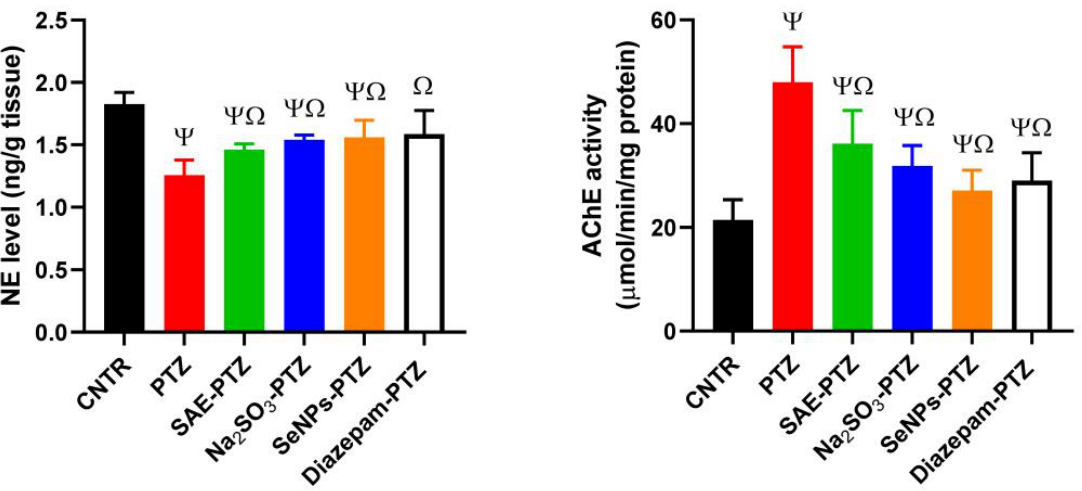
Figure 7. Effects of oral administration of Syzygium aromaticum extract (SAE), sodium selenite (Na 2 SeO 3 ), and green synthetized SeNPs using SAE (SAE-SeNPs) on the neurotransmitter norepi- nephrine (NE), and acetylcholinesterase (AChE) activity in cerebral cortex tissue against pen- tylenetetrazol (PTZ)-induced neurotransmission modulation ( n = 8). Ψ and Ω indicate significant differences ( p < 0.05) compared with the control and PTZ-exposed groups, respectively. All values are presented as the mean ± standard deviation (SD).